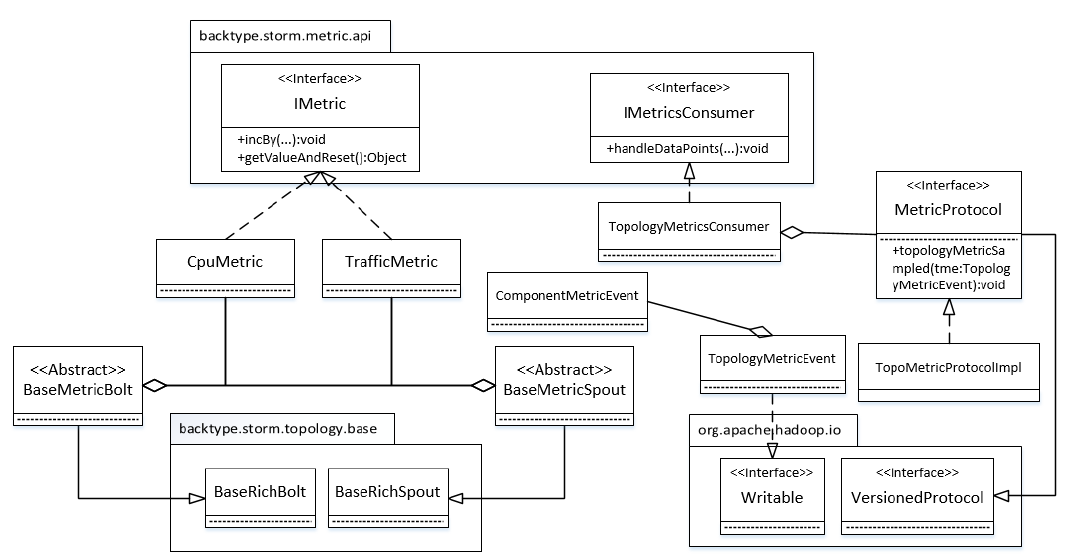
Figure 4. Metric sensor.